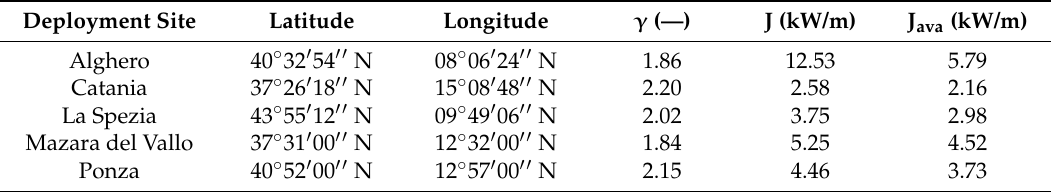
Figure 3. Frequency histograms of wave heights and periods at candidate deployment sites. Table 2. Main data of candidate sites along the Italian